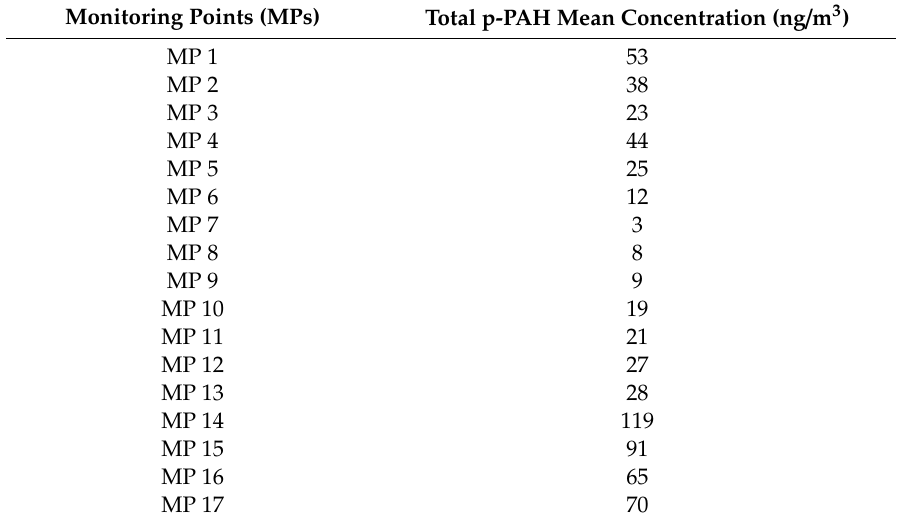
Figure 5. Total p-PAH mean concentrations during weekdays and Sundays at the Orsini site. Figure 5. Total p ‐ PAH mean concentrations during weekdays and Sundays at the Orsini site. Data Data collected from 1 August 2013 to 31 July 2014. collected from 1 August 2013 to 31 July 2014. Table 2. Average values of the total p-PAH concentrations at the 17 monitoring points (pit Table 2. Average values of the total p ‐ PAH concentrations at the 17 monitoring points (pit stops).